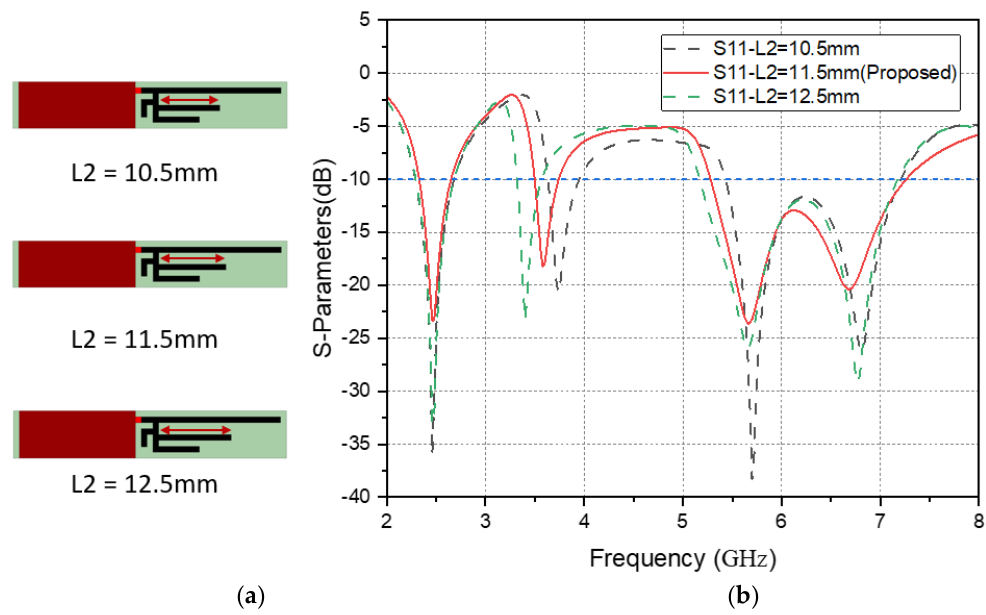
Figure 5. ( a ) Schematic diagram of L2 length variation of Ant. 1, ( b ) reflection coefficient (|S11|) of L2 length variation.